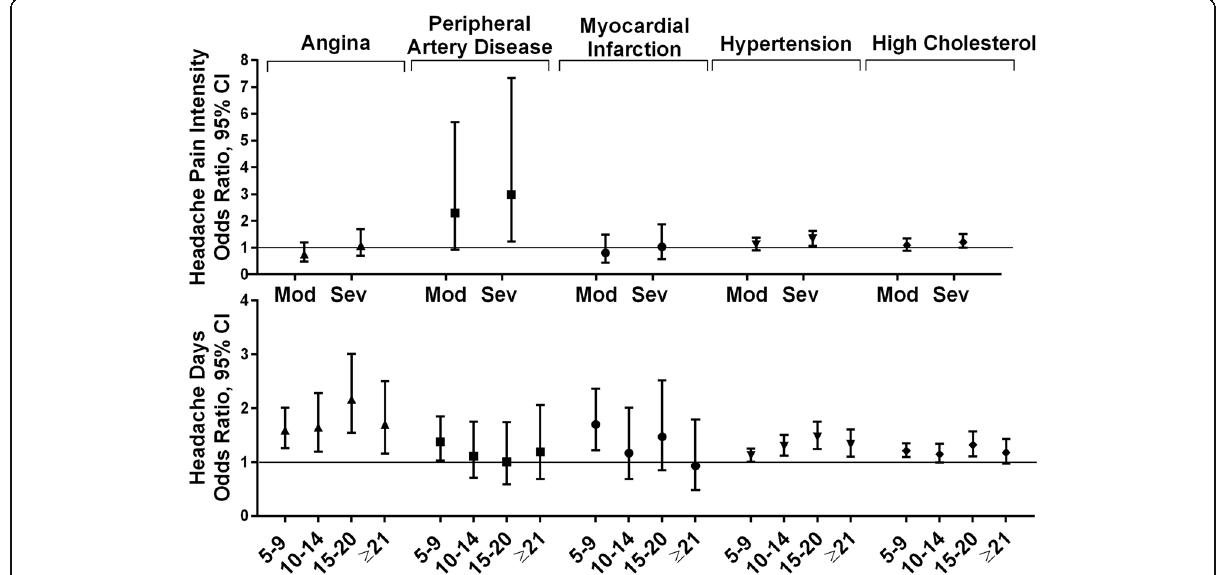
Fig. 2 Among persons with migraine the odds ratios (and 95% CI) for each comorbid cardiovascular condition*. *Fully adjusted models with sociodemographic characteristics (age, gender, Hispanic origin, race, marital status, employment, household income), headache pain intensity and headache frequency. Reference groups are low headache pain intensity for headache pain intensity and low frequency headache (1 – 4 MHDs)